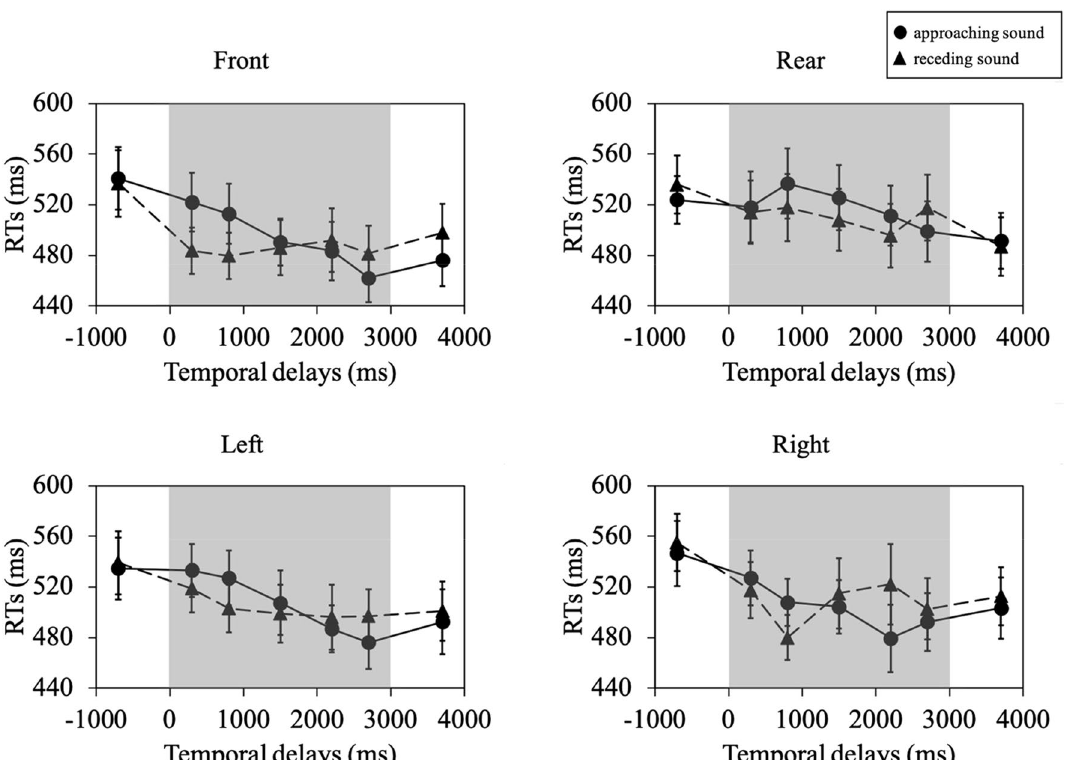
Figure 2. The results of the Experiment RTs (ms) as a function of the temporal delays (ms). Circular and triangular symbols indicate the approaching and receding sounds, respectively. The gray area indicates the timing of the pink-noise emission. Error bars represent standard